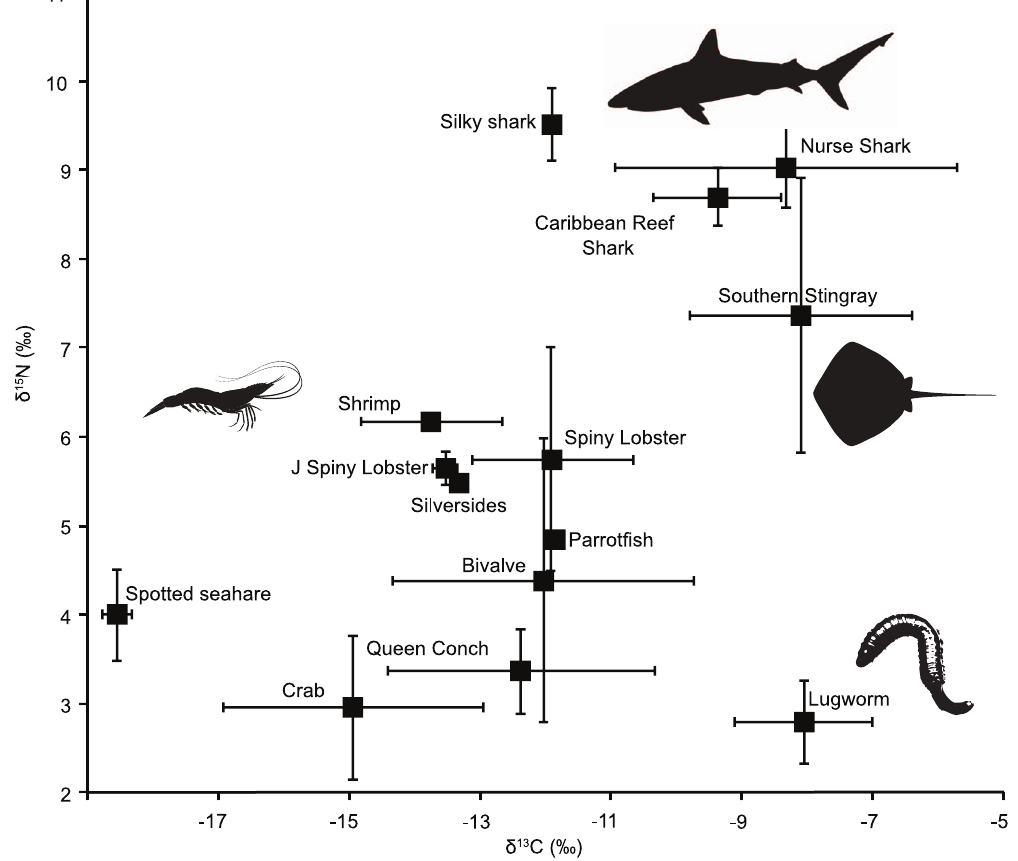
Figure 3. Bivariate plot of d 13 C vs. d 15 N values from tissue samples collected from D.americana , potential prey species, and sympatric shark species at Glovers Reef between 2008–2010. Values for D. americana, G. cirratum and C. perezi are displayed as combined mean ( 6 SD) skin and muscle tissues ( d 13 C 2 8.09 6 1.7, d 15 N 7.36 6 1.5; d 13 C 2 8.32 6 2.62, d 15 N 9.03 6 0.46; d 13 C 2 9.37 6 0.98, d 15 N 8.7 6 0.32 respectively).